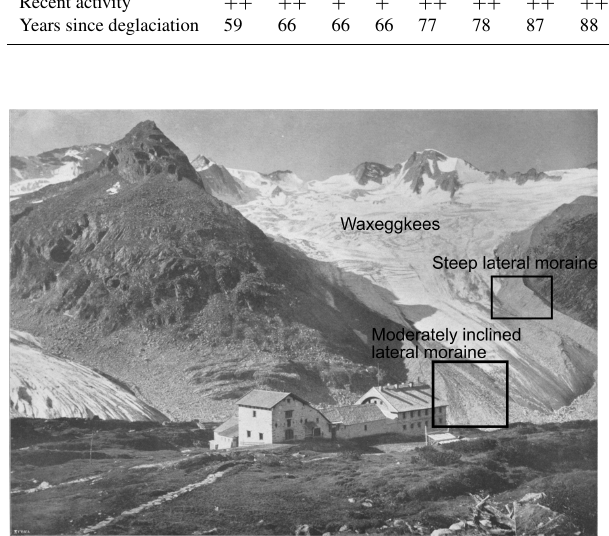
Figure 16. Photograph of the Waxeggkees showing lateral moraines with decreasing slope angle in the direction of the LIA maximum extent within the valley (Würthle&Sohn, Salzburg, in Platz and Rothpletz, 1903; courtesy of the Kulturarchiv Oberen-